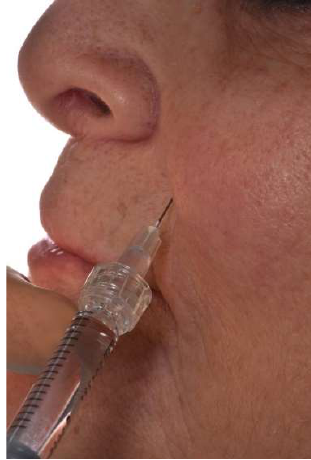
Figure 5. Injection of hyaluronic acid in front of the nasolabial folds in a patient rehabilitated by complete bimaxillary prostheses.